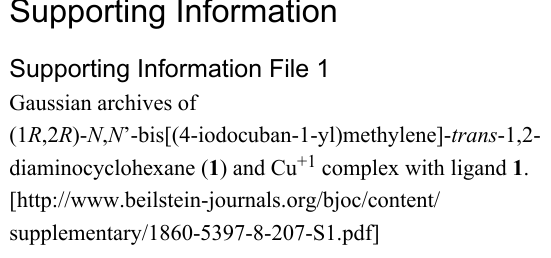
be stated that the H … Cu interaction is a true